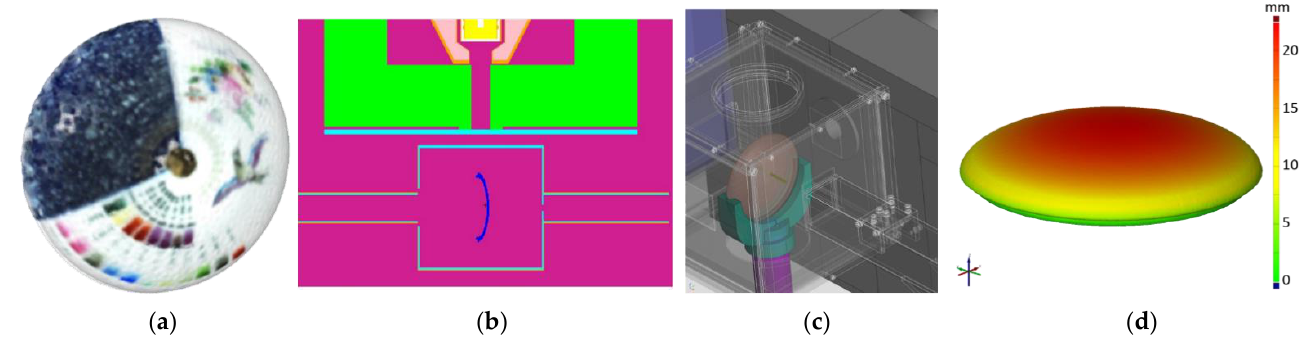
Figure 2. ( a ) the digital representation of the studied object obtained by 3D scanning, ( b ) the placement of the object in the MCNP6 simulation environment for PGAA matrix-effect correction, ( c ) the virtual model of the PGAI measurement geometry, visualizing the penetration of the pencil neutron beam, and ( d ) the elevation map for XRF scanning.